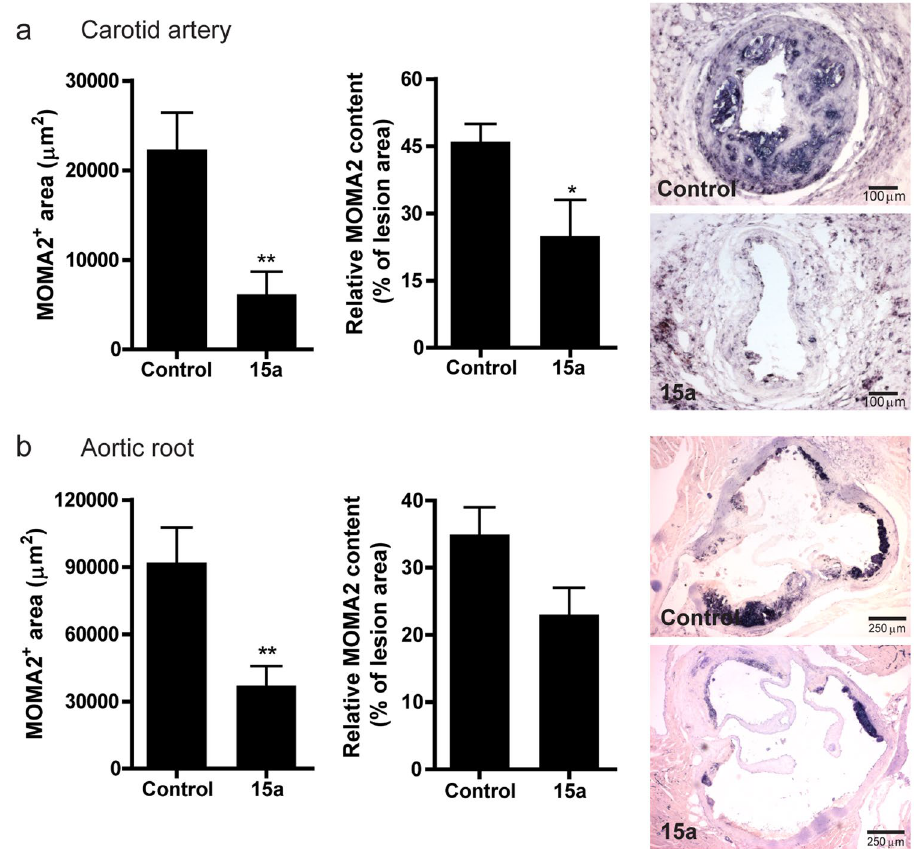
Figure 7. Macrophage content in carotid artery and aortic root atherosclerotic lesions. ( a ) Macrophage content in the carotid artery lesions as measured by MOMA2 staining was reduced upon treatment with 15a, both in total macrophage positive area (left panel) and relatively as percentage of lesion size (right panel). Micrographs show representative images of the individual groups (100X magnification). ( b ) Also in the aortic root, 15a significantly reduced the macrophage + area (left panel). Relative macrophage content did not significantly differ between the groups (right panel). Micrographs show representative images of the individual groups (40X magnification). * P < 0.05, ** P < 0.01. Graphs shown are representative from one experiment with n = 10 controls versus n = 9 15a-treated